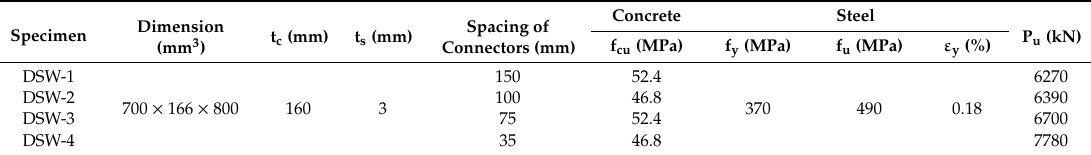
Table 1. Dimension and material properties of the SCS walls in